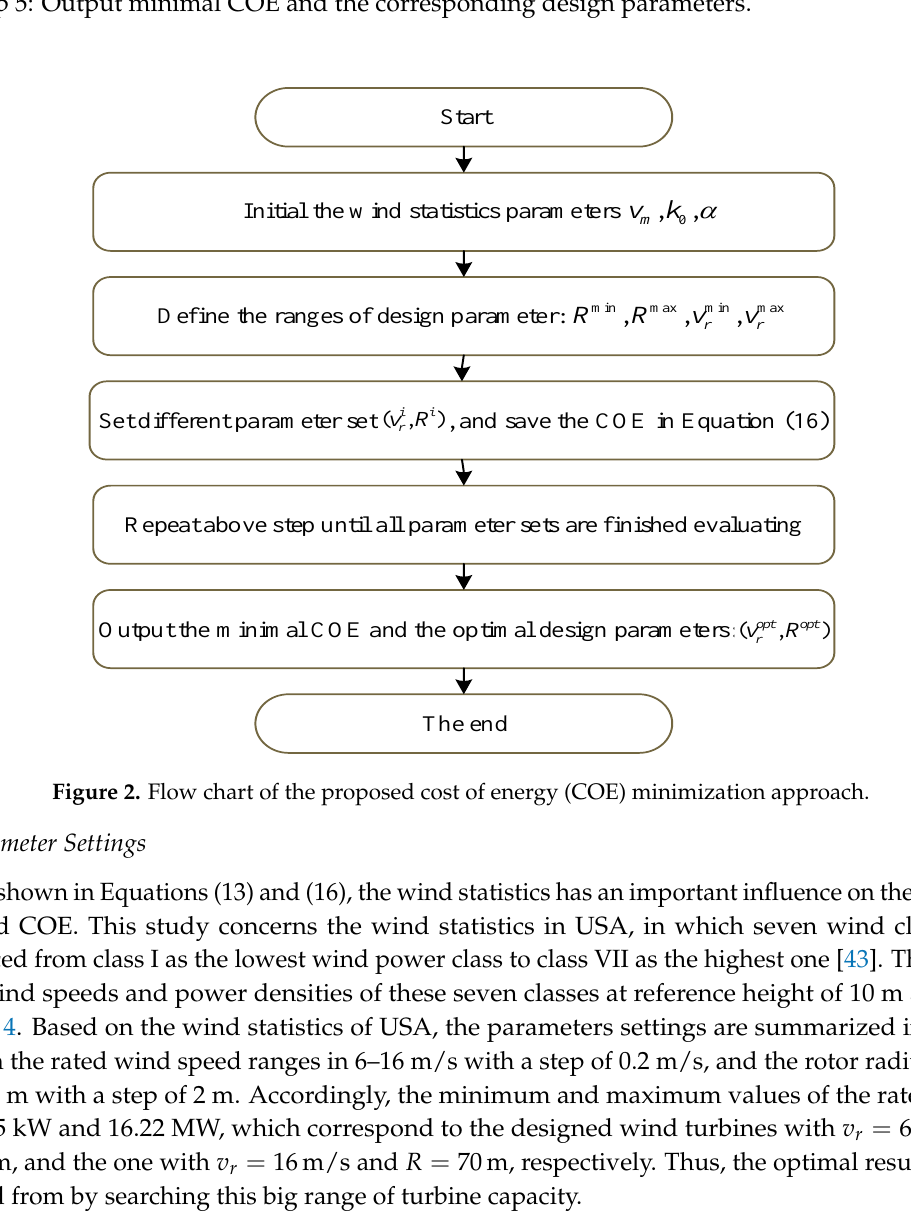
Table 4. Wind classification defined in USA